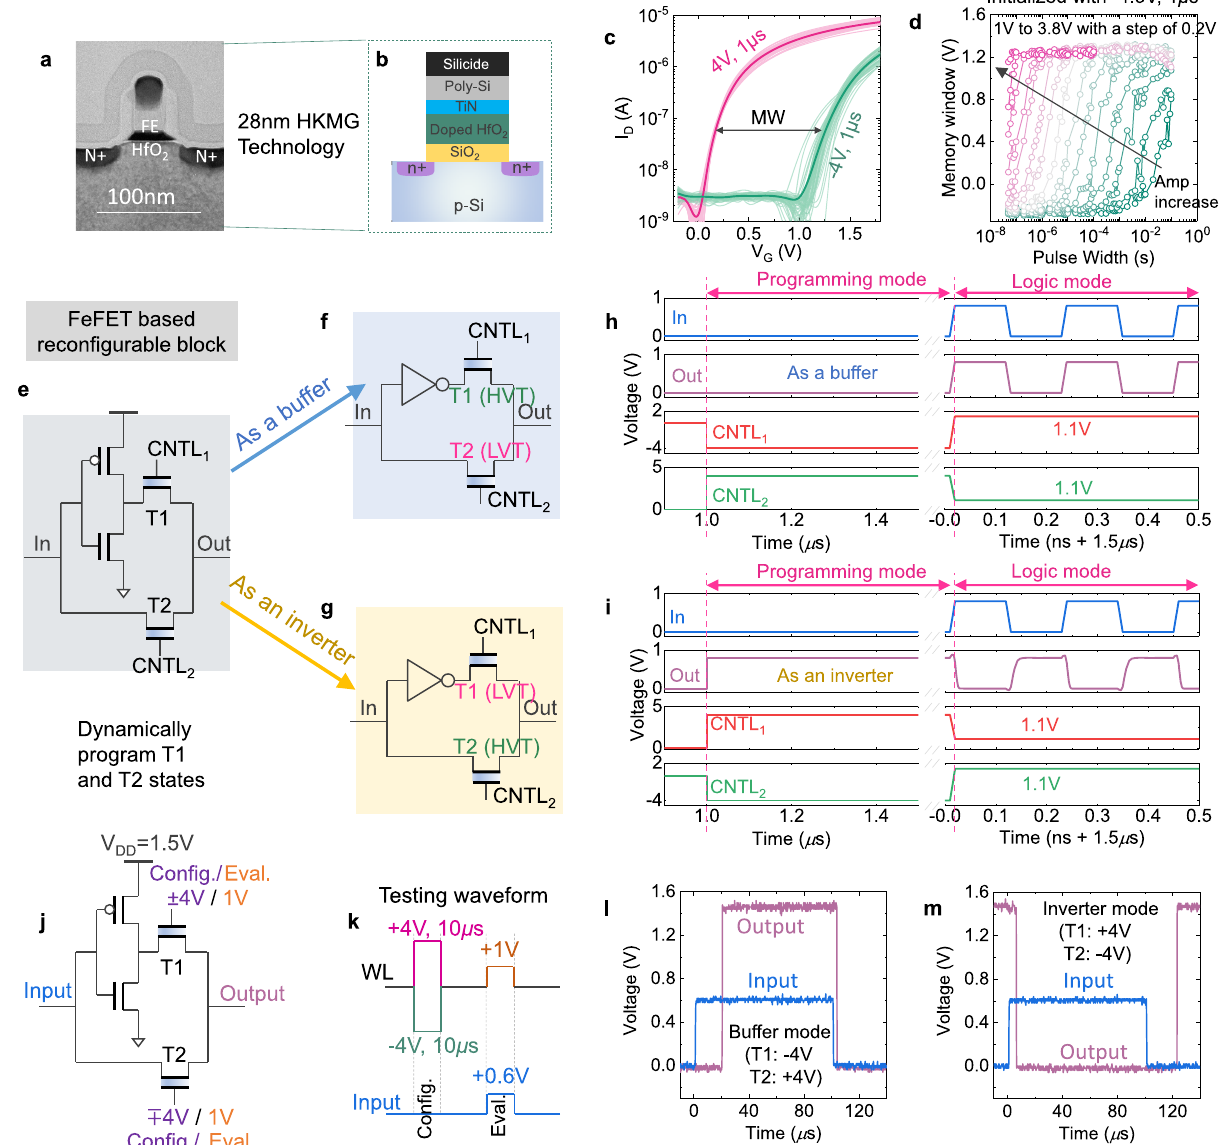
Fig. 2 FeFET recon fi gurable encryption block and its functionality veri fi cation. a TEM cross-section 38,43 and b schematic cross-section of an 28 nm high- κ metal gate FeFET device. c I – V D G characteristics of 60 different FeFETs measured after ±4 V, 1